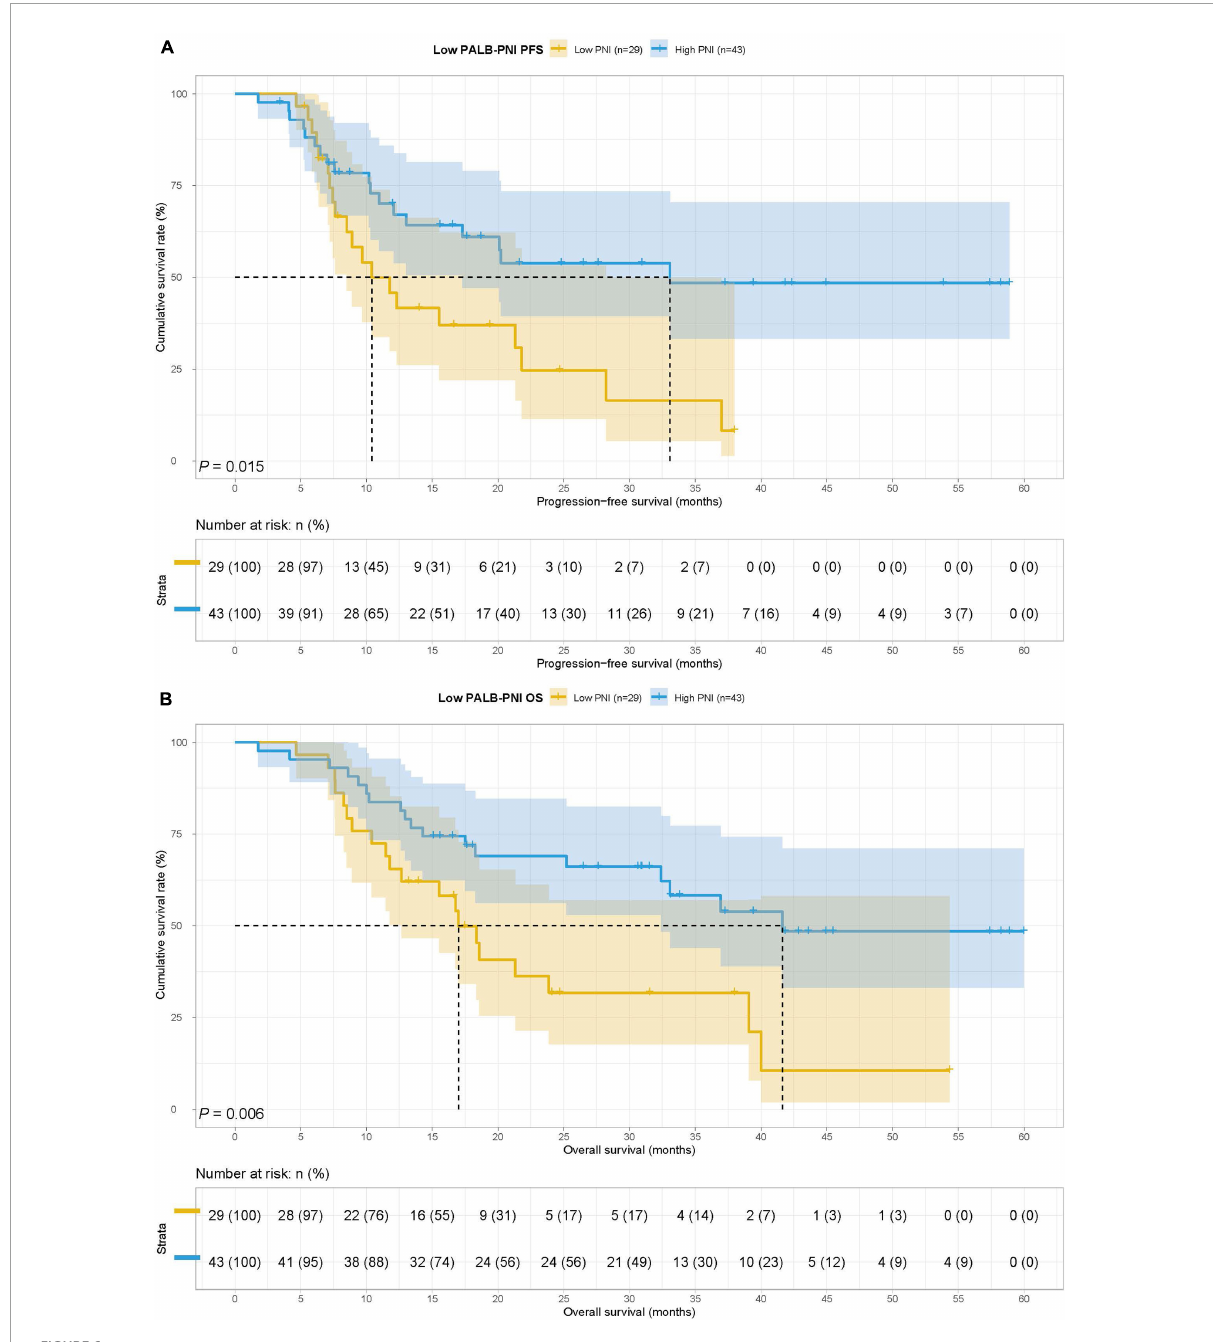
FIGURE6 Prognostic nutrition index related survival curve of (A) PFS and (B) OS in the low PALB group.